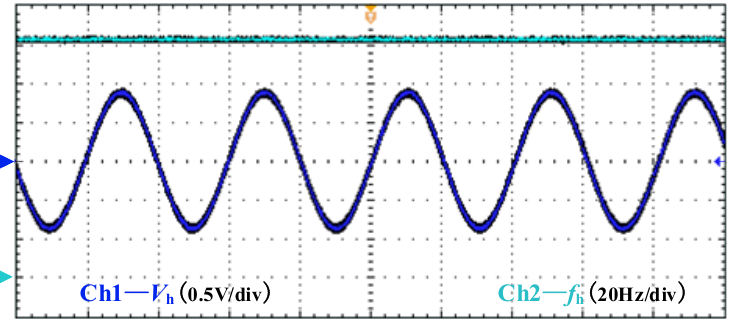
Figure 8. Injected harmonic signal ( x -axis: time, 0.004 s/div; y -axis: magnitude of the measured signal).